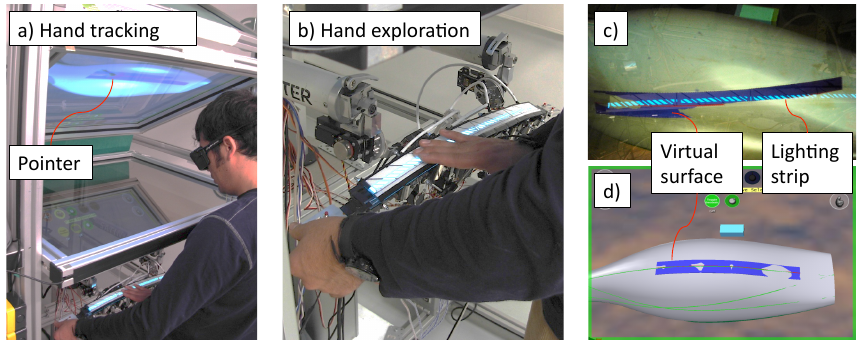
Figure 12. Exploring the virtual object.